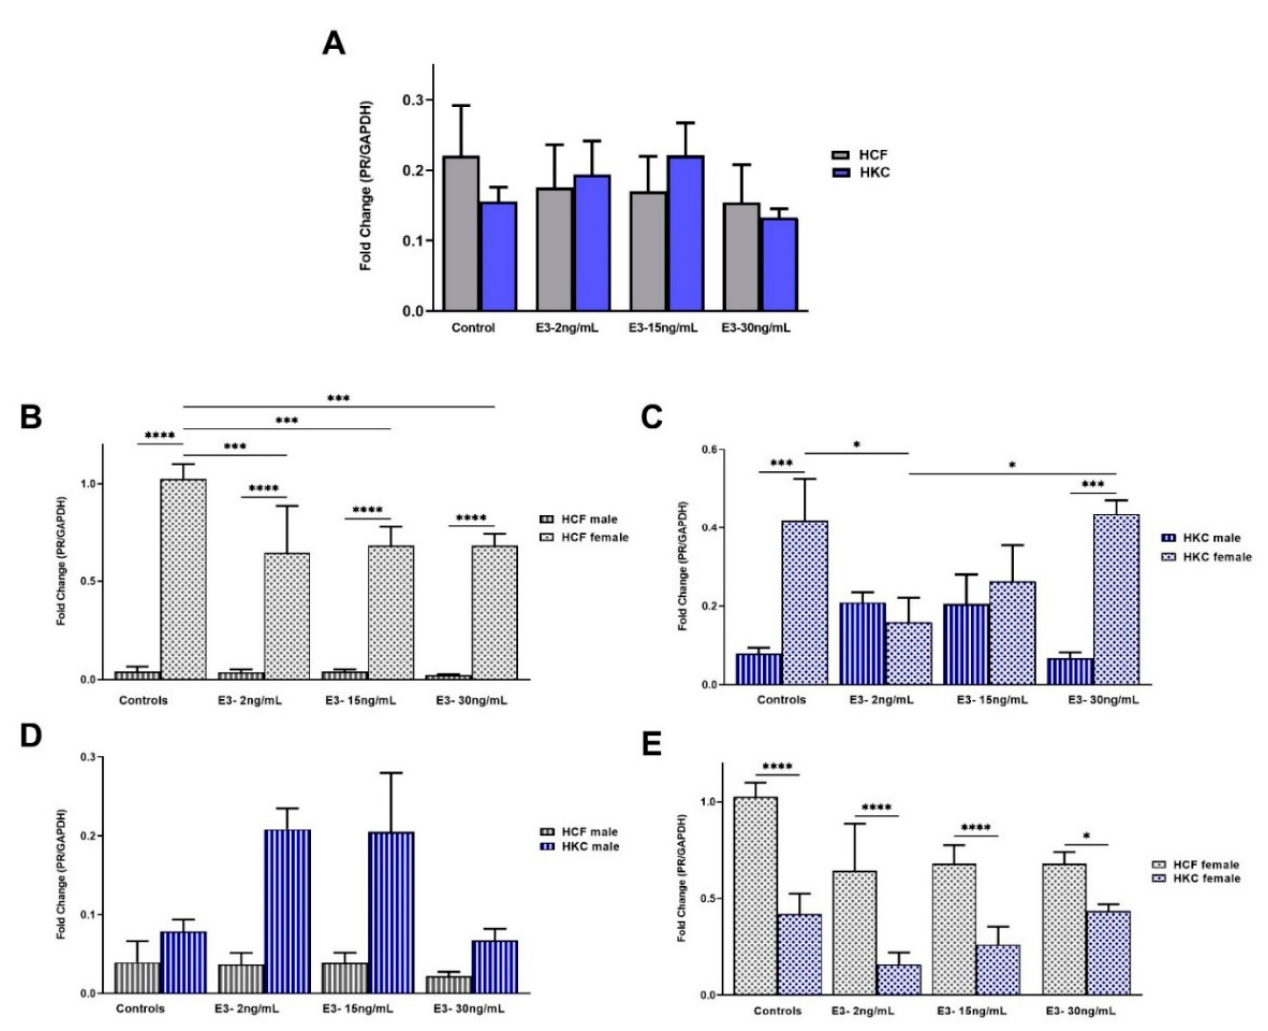
Figure 6. Expression of PR in 3D HCFs and HKCs in response to 2, 15, 30 ng/mL E3 stimulation for four weeks. ( A ) Overall PR expression in HCFs and HKCs ( n = 6). ( B ) Sex-specific expression of PR in HCFs ( n = 3) ( C ) Sex-specific PR expression in HKCs. ( D ) Male-specific PR expression in HCFs vs. HKCs. ( E ) Female-specific expression of PR in HCFs vs. HKCs. * p < 0.05, *** p < 0.001, and **** p < 0.0001.